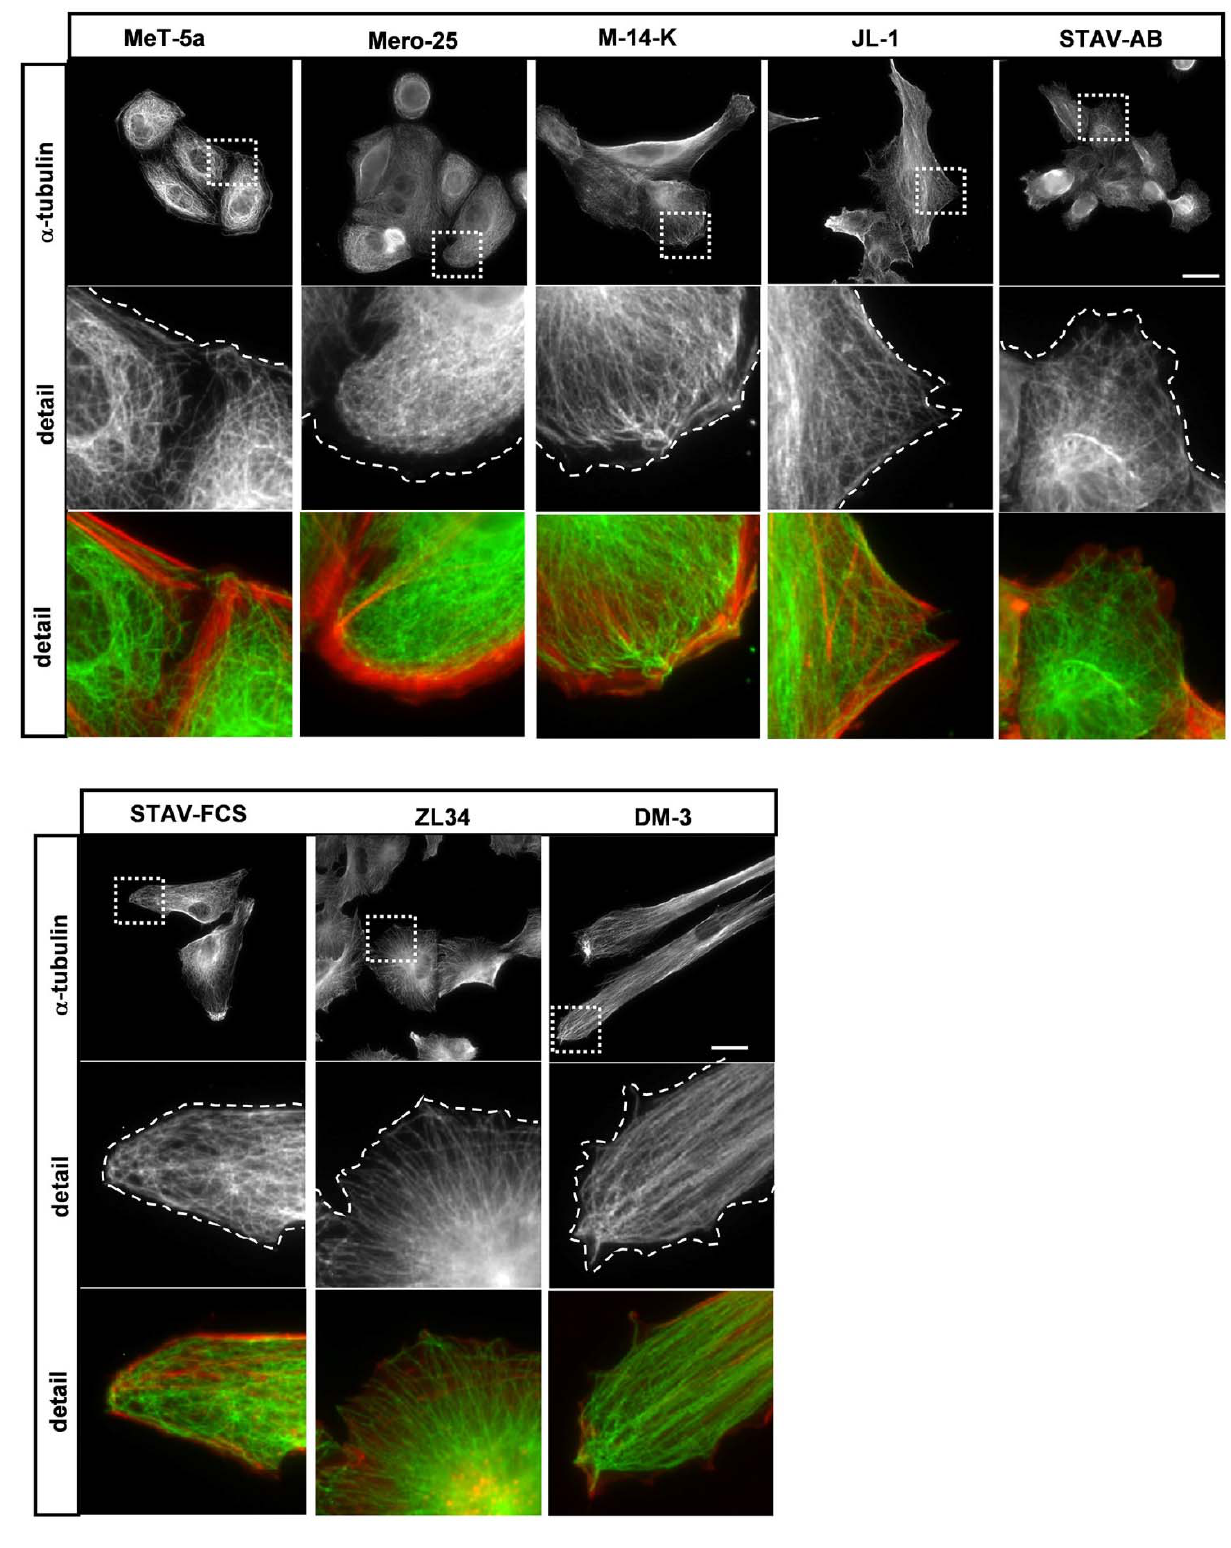
Figure 3. Organization of microtubules. Representative images for microtubule visualization with a mouse anti– α -tubulin antibody followed by an AlexaFluor488-conjugated goat anti-mouse antibody. Filamentous actin visualized with TRITC- conjugated phalloidin, Scale bar, 20 µm. The dashed lines mark the location of the cell edge. The MTs are under a scheme of constant reconstruction, individual MTs undergo cycles of growth and shrinkage in a process known as dynamic instability [18]. More long-